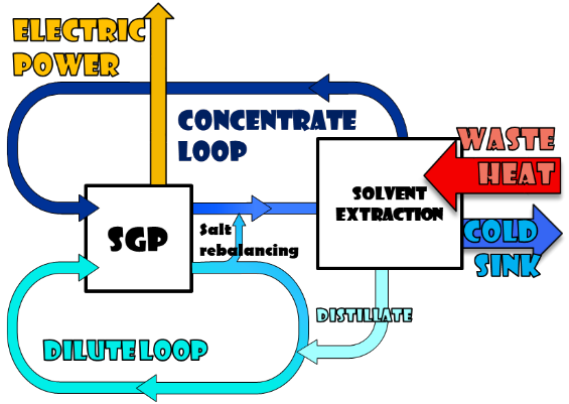
Figure 2. Reverse Electrodialysis (RED)-heat engine scheme: RED coupled with a solvent extraction technology. Only a few works in the literature are focused on the case of “ solvent extraction scheme